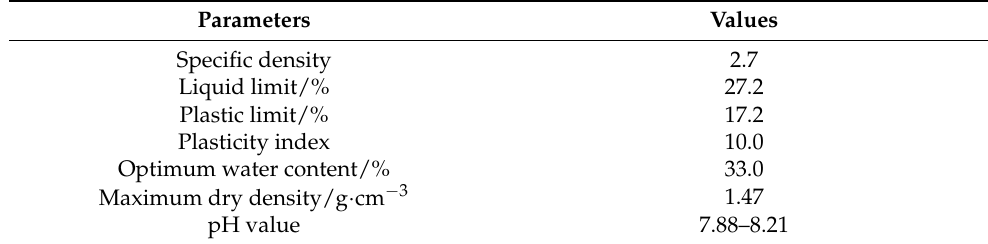
Table 1. Main physical properties of RLC.